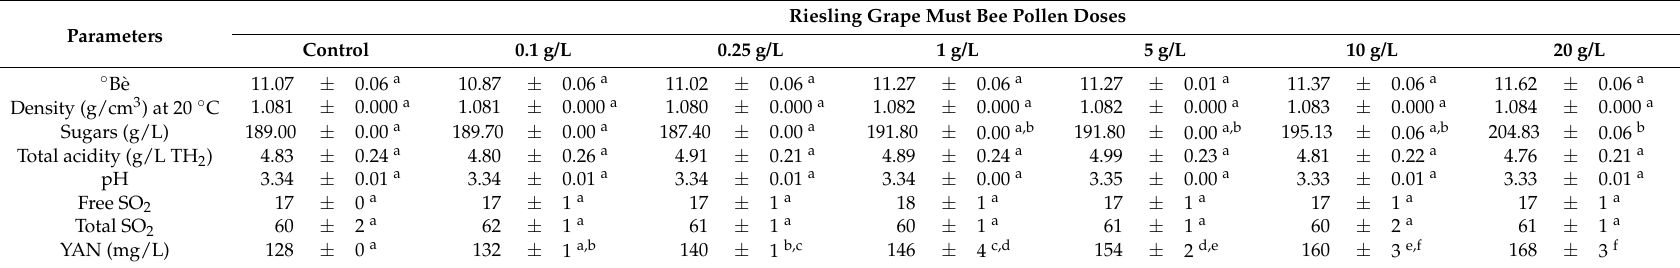
Table 2. Physico-chemical parameters of Riesling grape must with addition of bee pollen (0.1, 0.25, 1, 5, 10 and 20 g/L) and control.